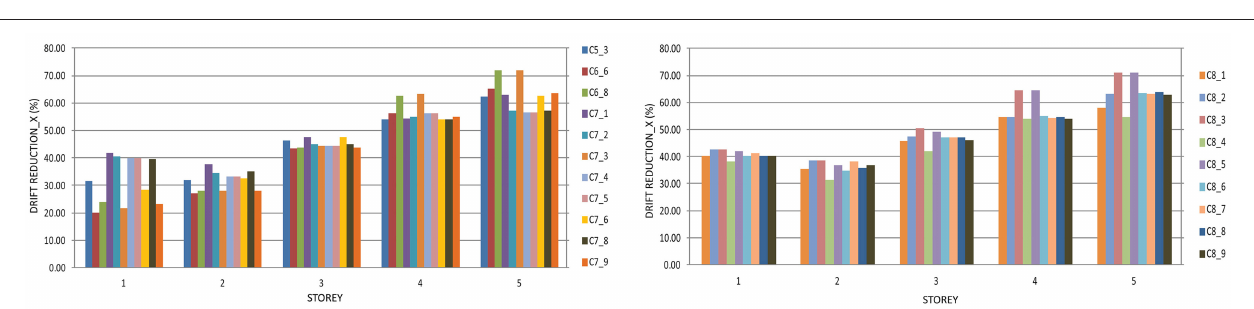
defined with EC8 as the previously mentioned limitation factor.